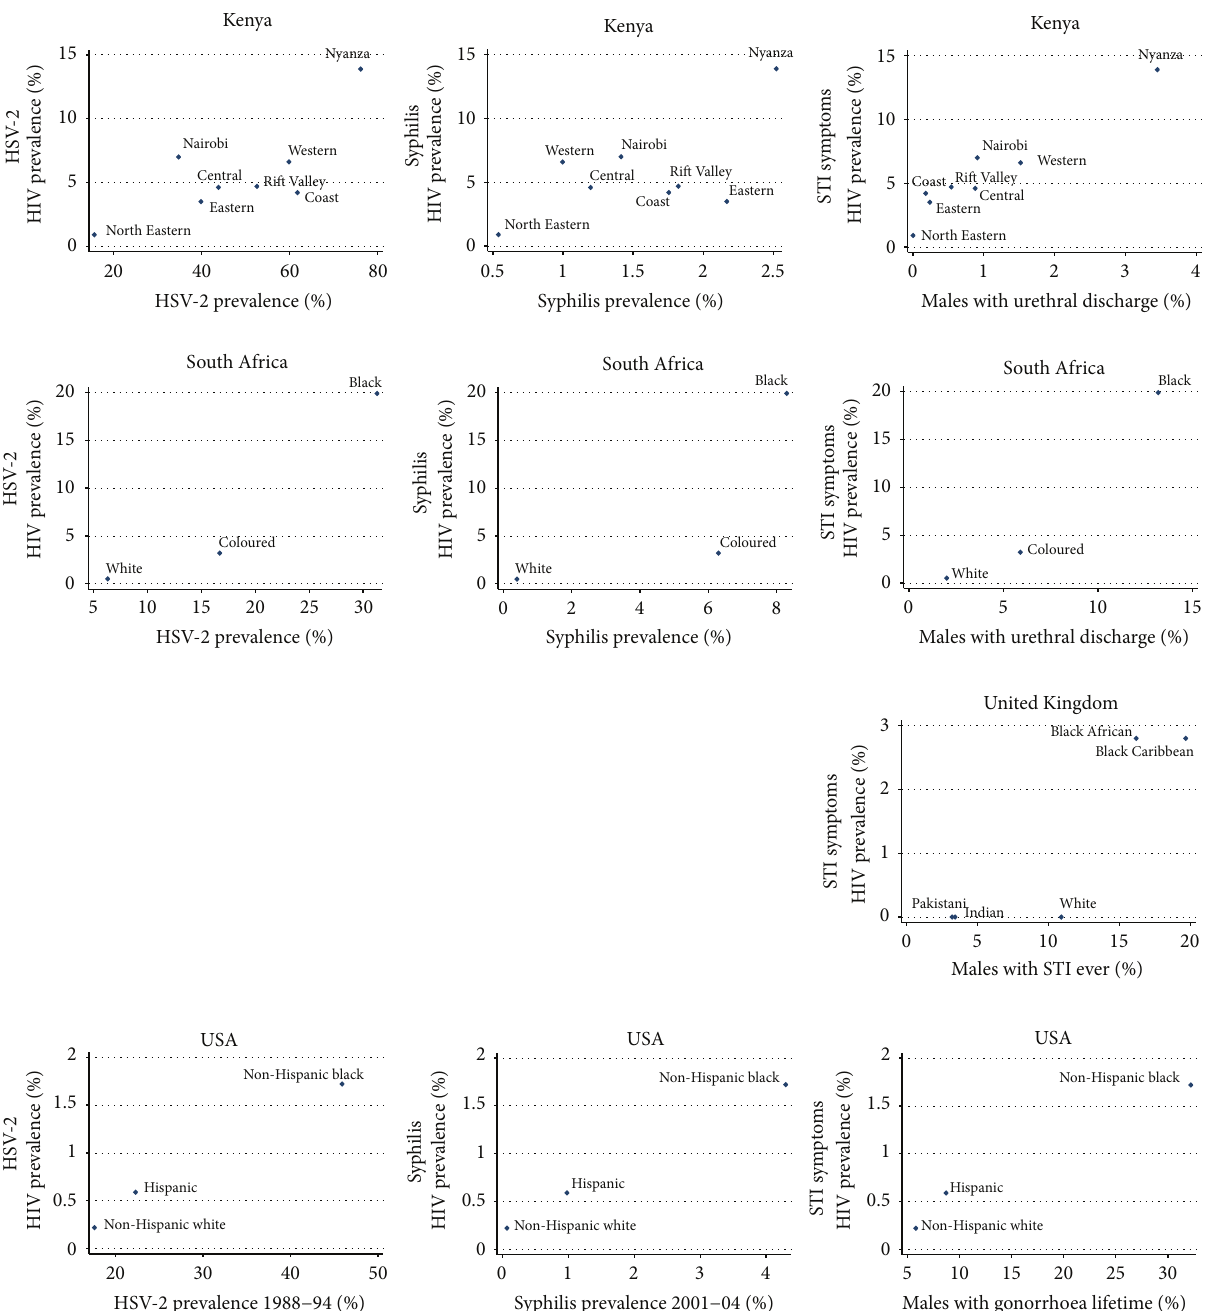
Figure 1: The prevalence of HSV-2, syphilis, and symptomatic STI versus HIV prevalence by ethnic group in Kenya, South Africa, the United Kingdom, and the United States of